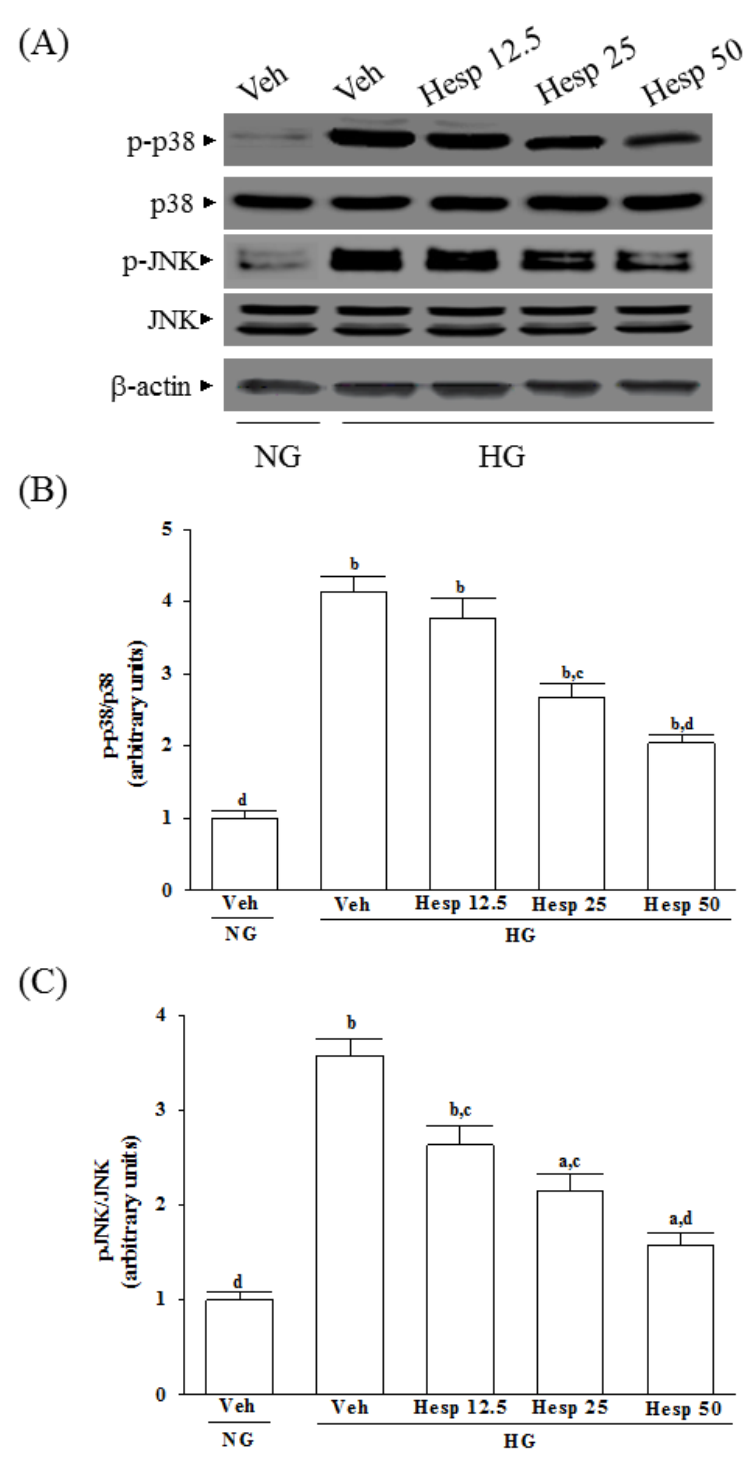
Figure 5. Effect of hesperidin on p38 and c-Jun N-terminal kinases (JNK) activation in high glucose cultured RGC-5 cells. ( A ) The photographs were representatives the Western blots for p-p38, p38, p-JNK, JNK and β -actin. Five western blots in each group were tested; ( B ) The ratio of p-p38/p38 was calculated; ( C ) The ratio of p-JNK/JNK was calculated. The results are presented as the mean ± SD of five independent experiments ( n = 5), each of which was performed in triplicate. a p < 0.05 and b p < 0.01 when compared with the normal-glucose vehicle (Veh)-treated group. c p < 0.05 and d p < 0.01 when compared with the high-glucose vehicle-treated group.